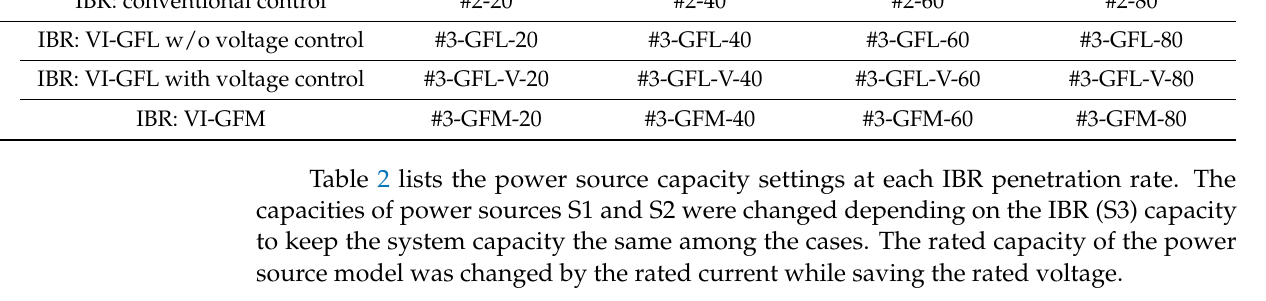
Table 2. Rated capacities of the generation units at each IBR penetration rate.